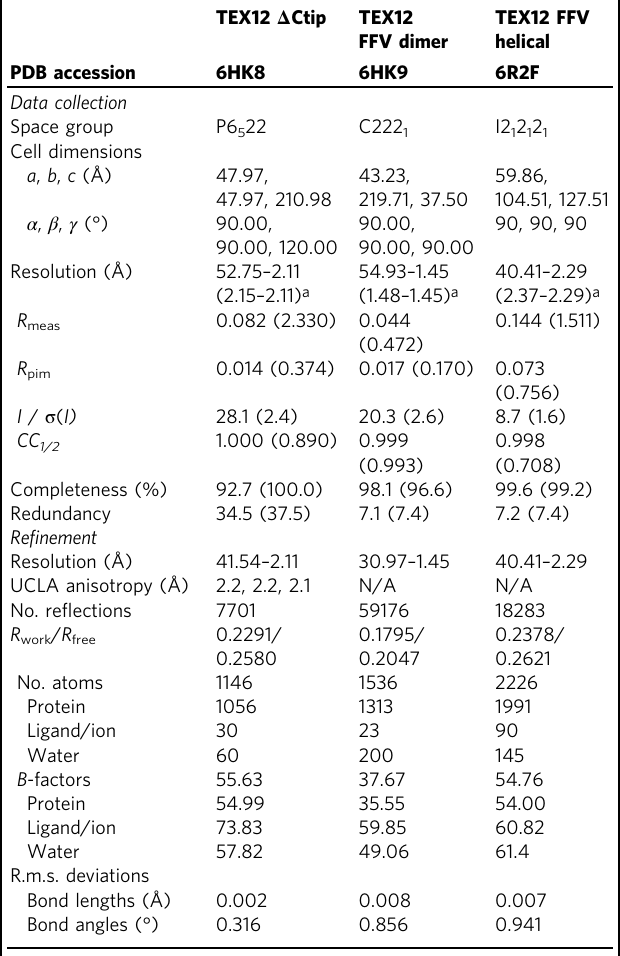
Table 1 Data collection, phasing and re fi nement